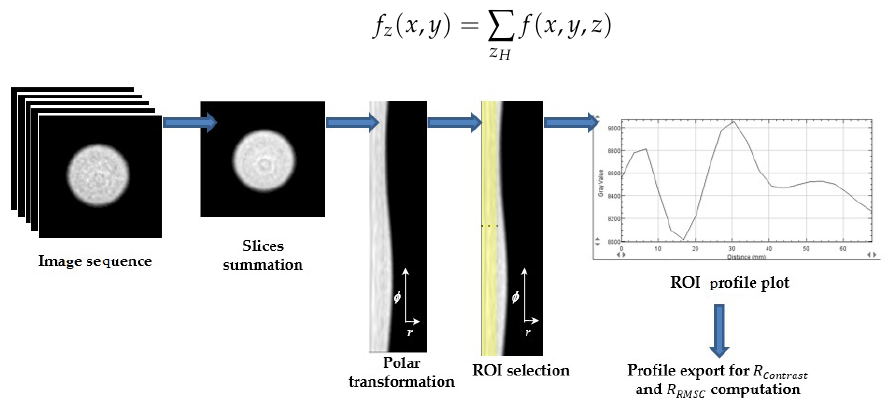
Figure 5. Workflow used to obtain radial features (i.e., R Contrast and R RMSC ) from SPECT data sets.